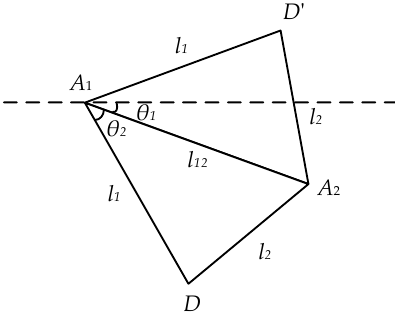
Figure 11. Location calculation based on symmetry.